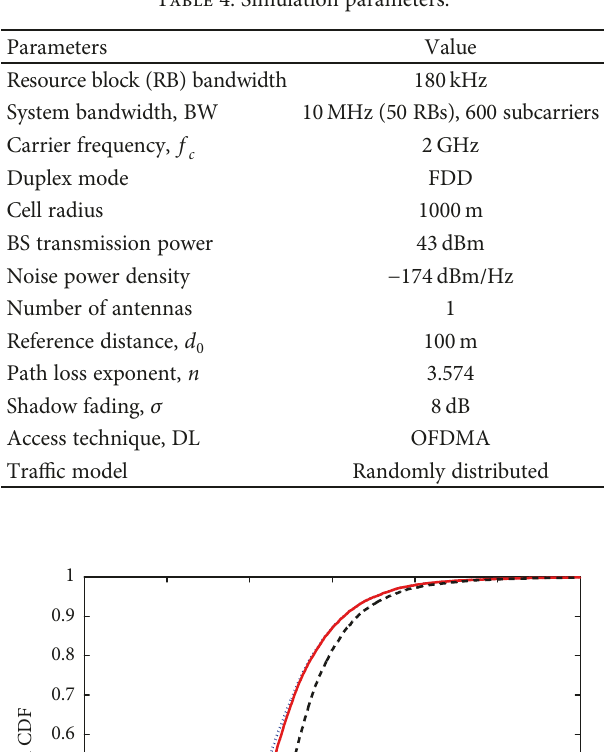
Table 4: Simulation parameters.